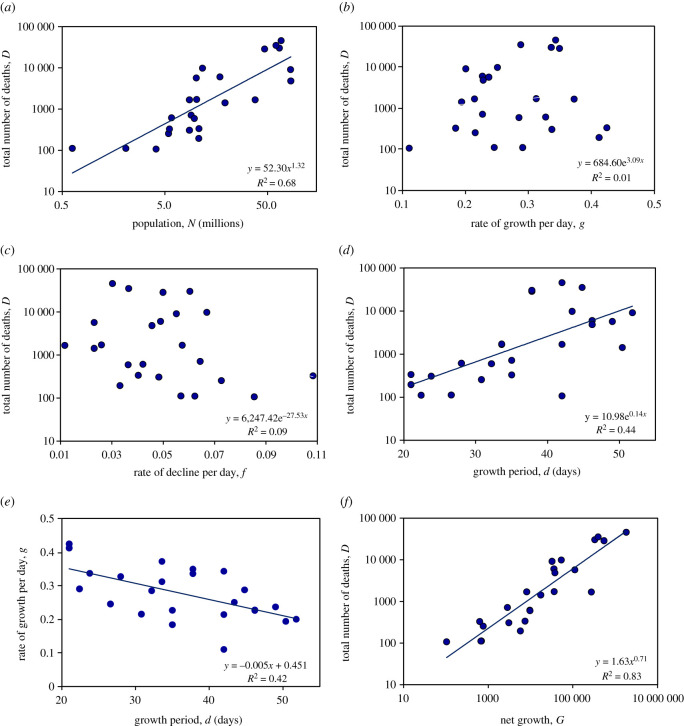
Determinants of the total number of reported COVID-19 deaths in each of 24 European countries, using estimates derived from the skew-logistic model (figure 2). (a) The number of deaths increased with national population size. The number of deaths varied independently of (b) the rate of epidemic growth and (c) decline. But (d) more deaths were reported when epidemics were allowed to grow for longer, even though (e) longer periods of growth were associated with lower epidemic growth rates. (f) The number of deaths was strongly associated with growth rate and period combined as net growth, G=egd. Each panel gives the regression equation (regression line shown if statistically significant) and the fraction of the variation explained by each independent variable (R2). Data source [1].